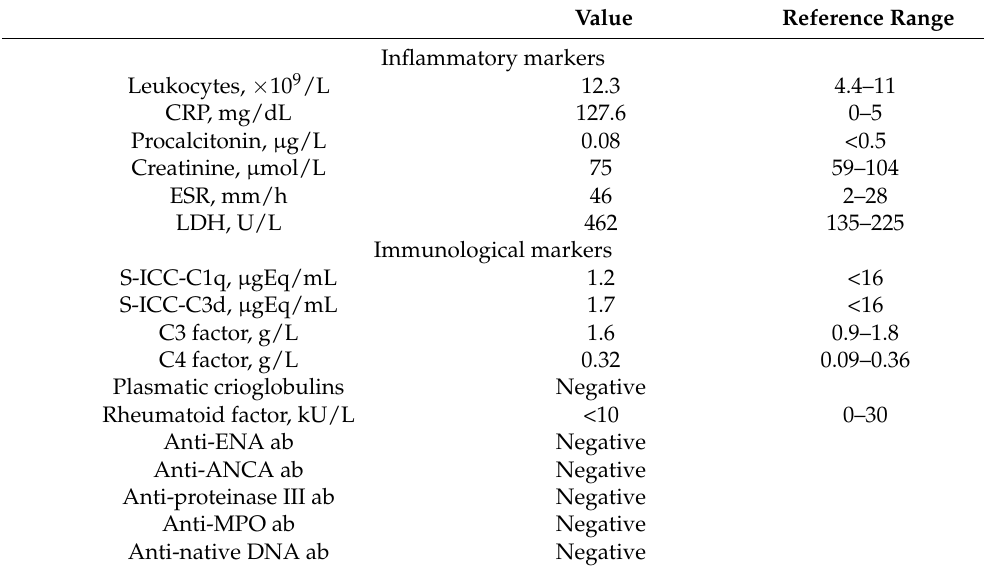
Table 1. An increase in inflammatory markers is compatible with renal infarction. Immunological markers were all negative. An increase in coagulation factors activity, especially factor II, VIII, IX, X, X, and fibrinogen is coherent with the pathophysiology of thromboembolism described in COVID-19 [8–10].